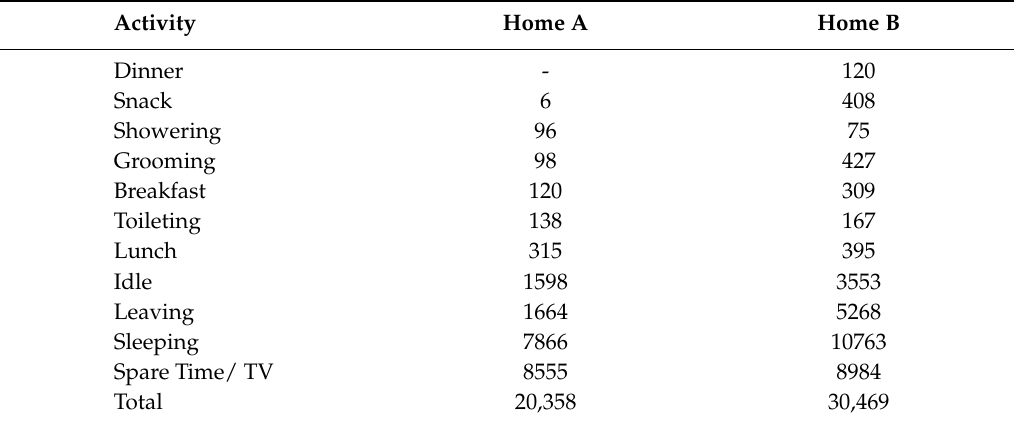
Table 2. Frequency of activities in the Ordonez